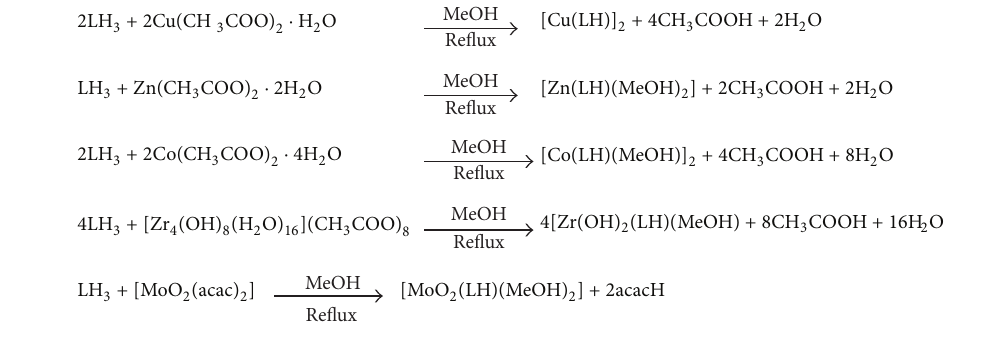
Scheme 2: Preparative scheme of coordination compounds of LH 3 ( I ).